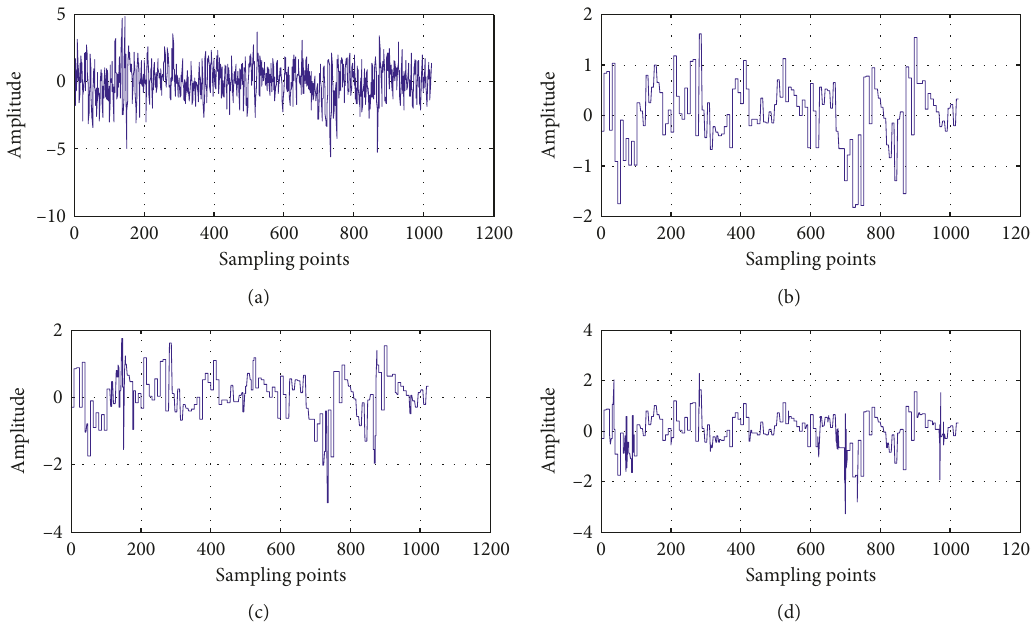
Figure 9: Rolling wear signal and the waveform after denoising. (a) Rolling wear signal. (b) Hard threshold denoised signal. (c) Default threshold denoised signal. (d) Given soft threshold denoised signal.